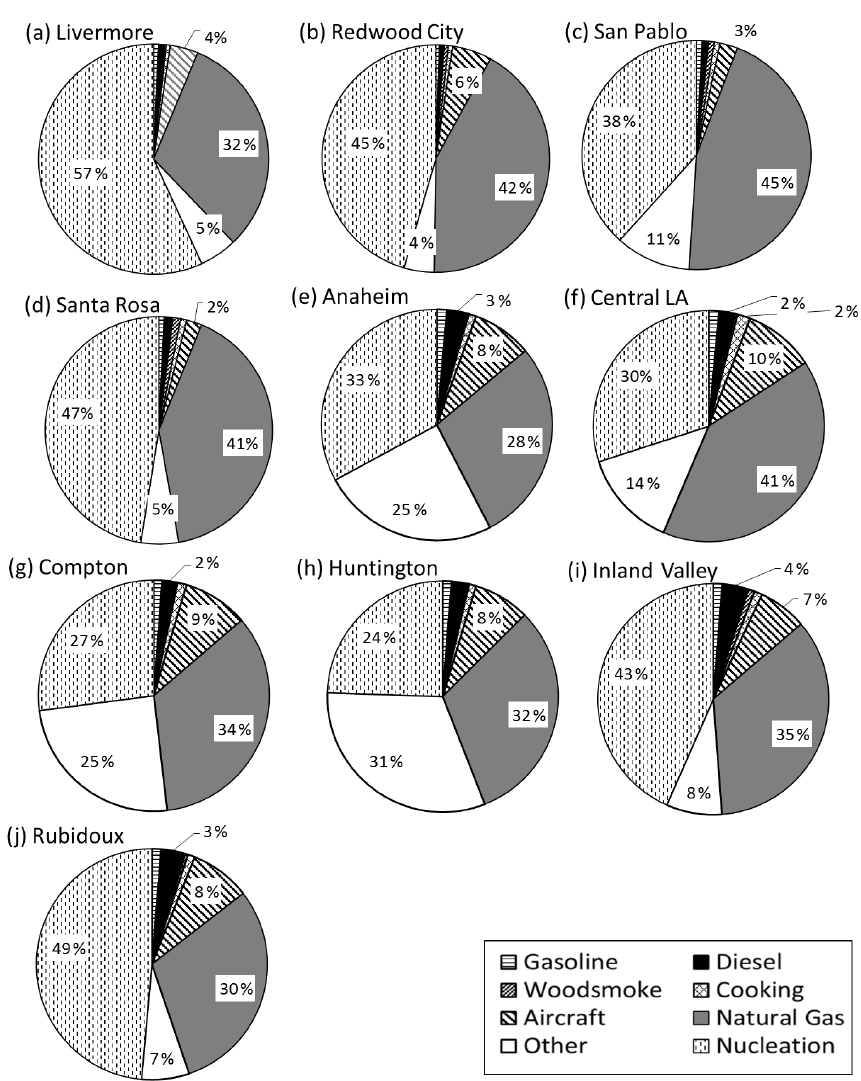
Figure 13. The relative source contributions to N 10 at Livermore, Redwood City, San Pablo, Santa Rosa, Anaheim, central LA, Compton, Huntington, Inland Valley, and Rubidoux, respectively. Averaging time included all days shown in Figs. 7–9. Values not displayed are ≤